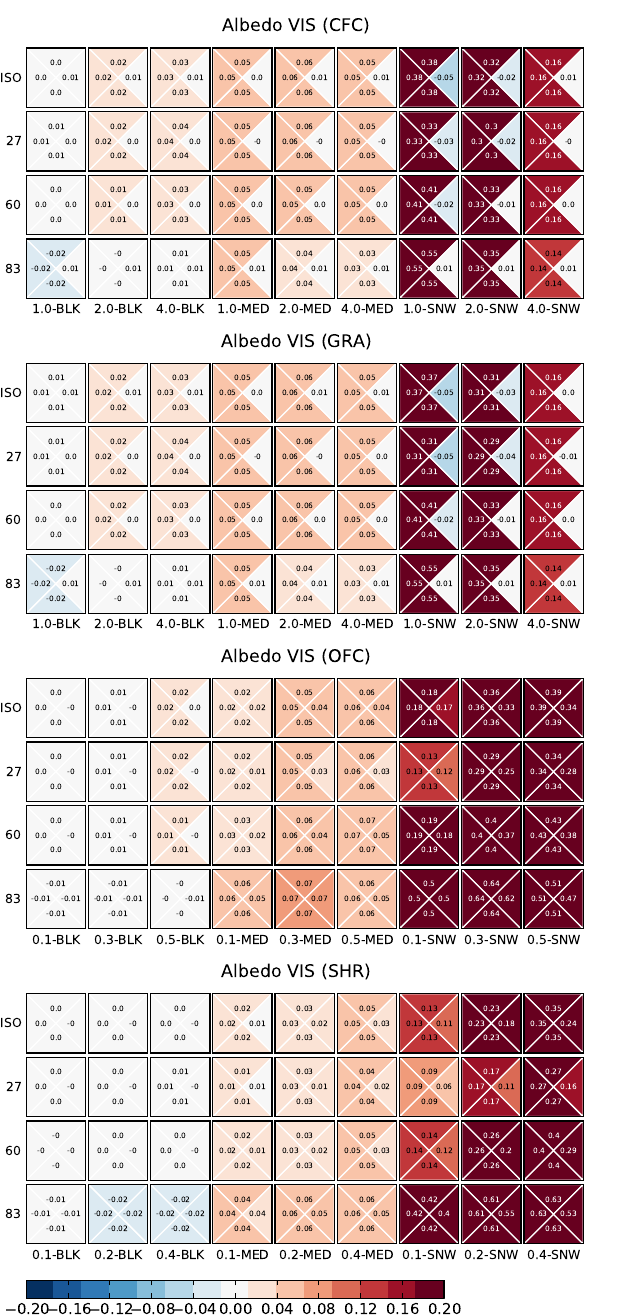
Figure 5 shows surface albedo deviations for the entire solar spectrum. The following figures show the deviations of surface albedo for the visible and near infrared shortwave bands separately.